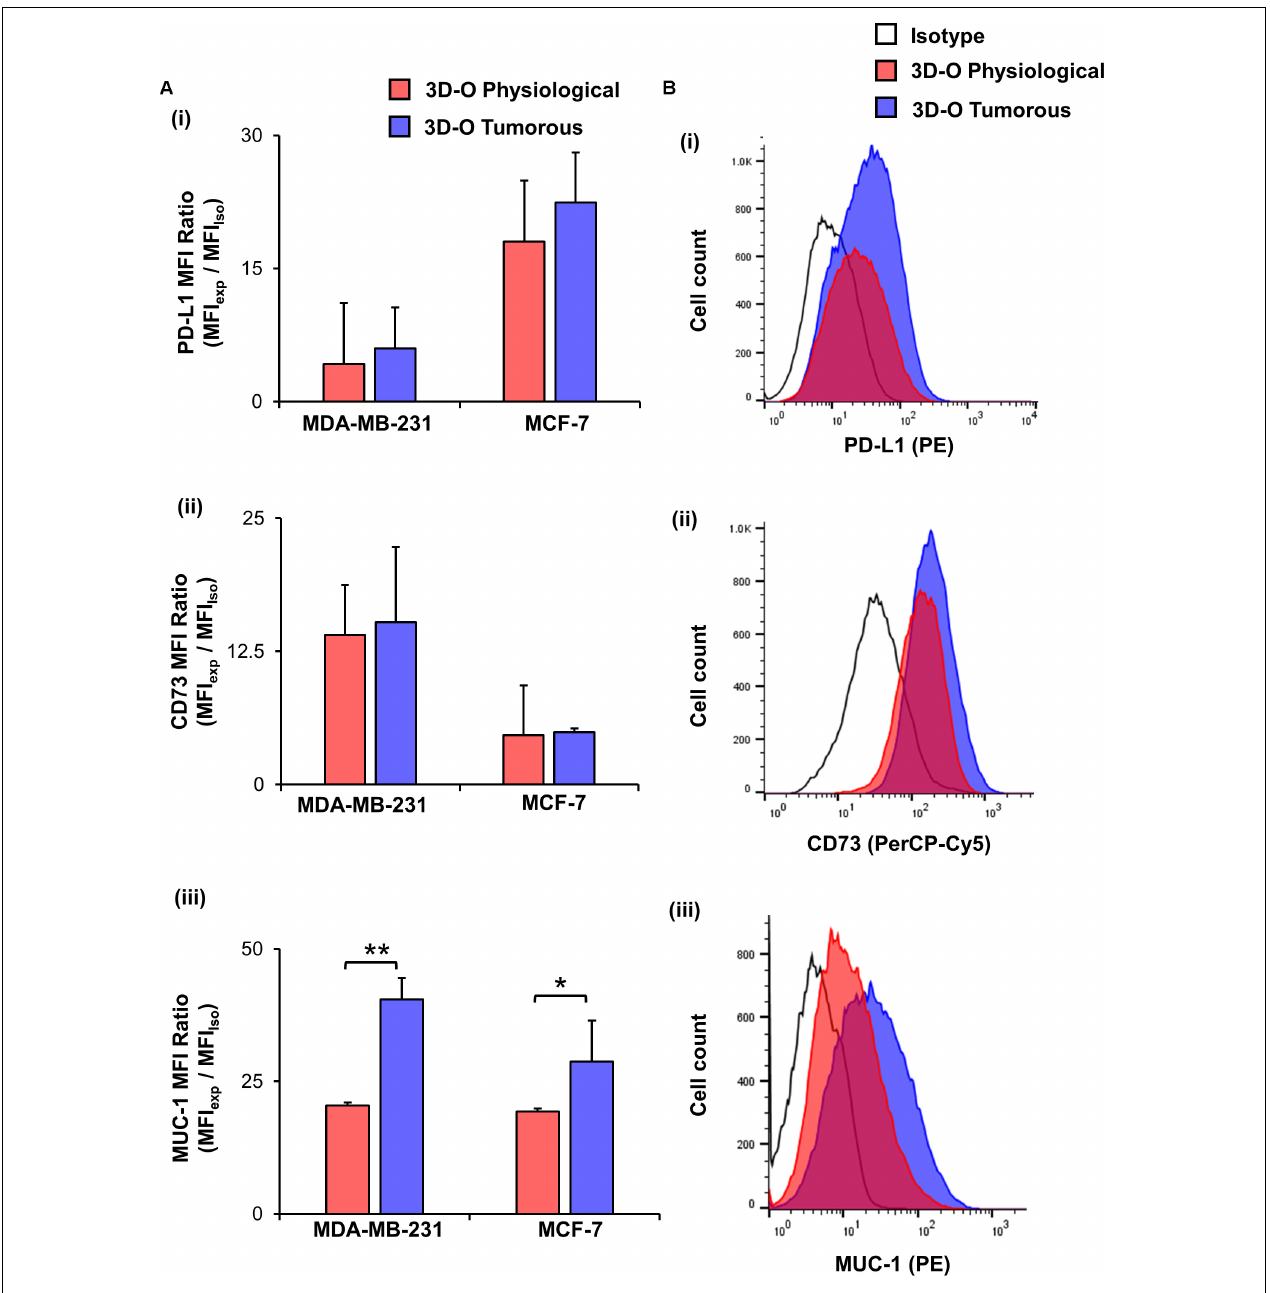
FIGURE 6 | Low-oxygen within 3D-O matrices moderately enhances immune surface marker expression. (A) Immune surface marker expression by BCa cells grown in 3D-O physiological and 3D-O tumorous matrices after 4 days quantified as MFI ratio for PD-L1 (i) , CD73 (ii) , and MUC-1 (iii) . (B) Flow cytometry representative histograms for PD-L1 (i) , CD73 (ii) , and MUC-1 (iii) ** p < 0.001, * p < 0.05, data were analyzed using unpaired two-tailed Student’s t